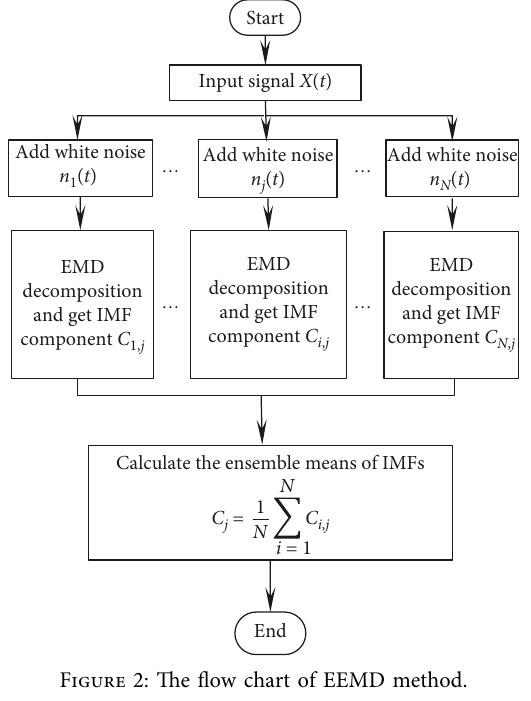
Figure 2: The flow chart of EEMD